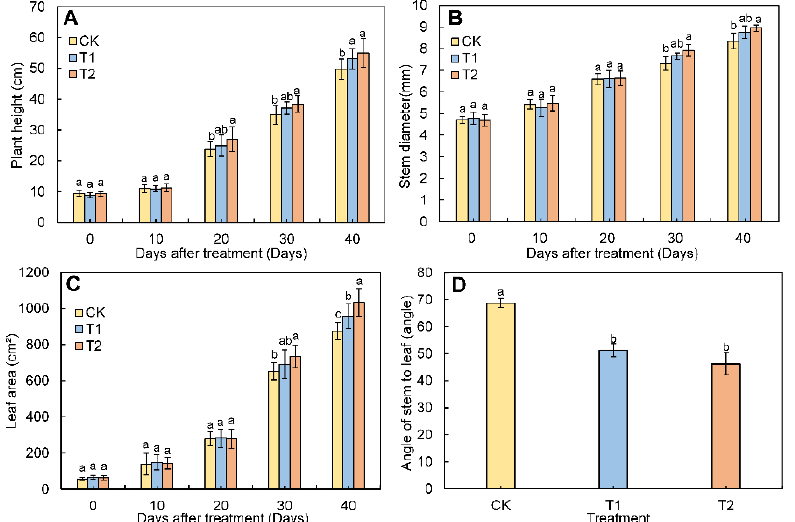
Figure 2. Plant height ( A ), stem diameter ( B ), leaf area ( C ), and angle of stem and leaf ( D ) of tomato plants exposed to different LED light supplementation durations. Data are expressed as average values ( n = 3). Different lowercase letters indicate significant differences between treatments determined using Duncan’s multiple range test ( p < 0.05). Standard errors are indicated by bars. CK: no light supplementation or control; T1: light supplementation for 3 h in the morning; T2: light supplementation for 3 h in the evening.